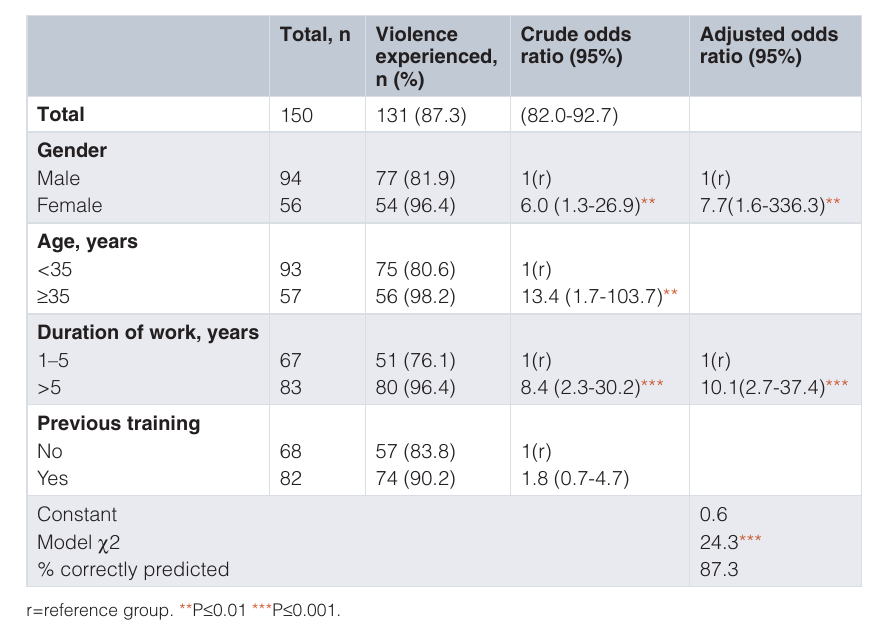
Table 2. Prevention tactics for workplace violence reported by security personnel at a university hospital in Egypt (n=150). Measure to prevent violence Train workers on how to prevent